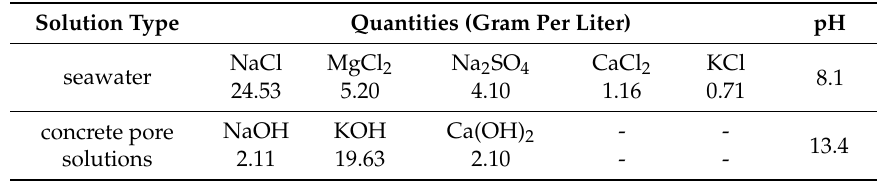
Table 3. Compositions of simulated seawater and concrete pore solutions.